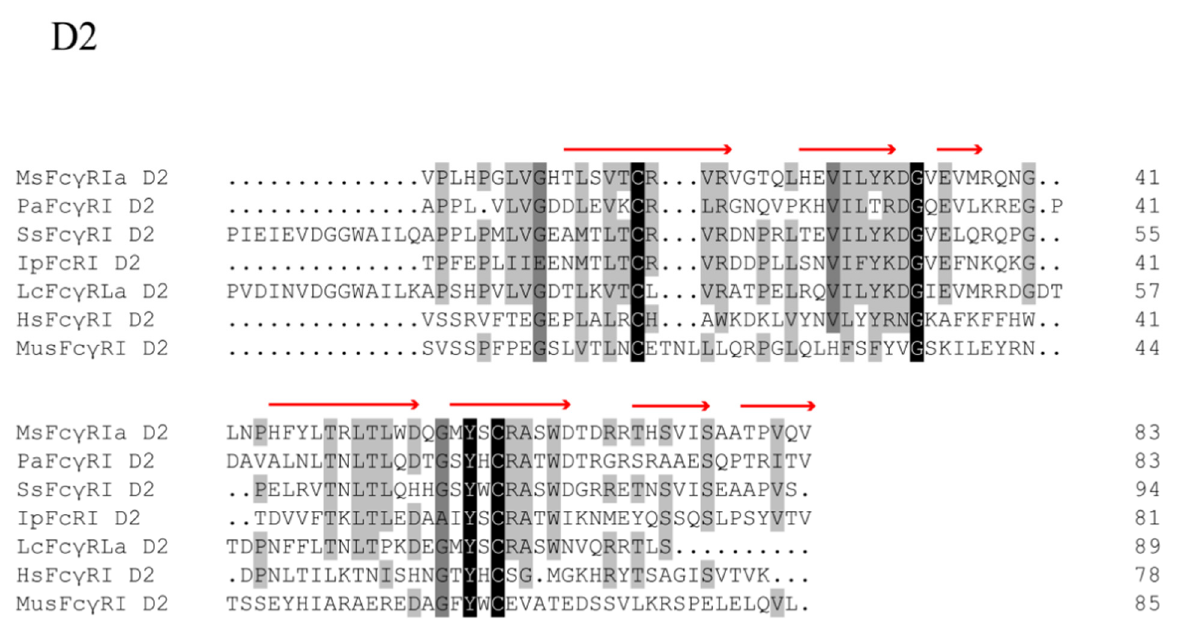
Figure 2. Analysis of MsFc γ RI α protein sequences. ( A ) Schematic representation of MsFc γ RI α protein. The red line on the left and the purple line on the right represents signal peptide and low complexity domain, respectively. ( B ) Amino acid alignments of D1 and D2 of largemouth bass, ayu, Atlantic salmon, channel catfish, large yellow croaker, human and mouse representative Fc γ Rs. Hatched boxes indicate conserved cysteines, and dashes (-) represent gaps. MsFc γ RI α : Largemouth bass Fc γ RI α (ULE36159.1); PaFcRI: Ayu (MG687271); SsFc γ RI: Atlantic salmon Fc γ RI (XM014162558); IpFcRI: Channel catfish FcRI (DQ286290); LcFcRL α : Large yellow croaker FcRLa (XM010738182); HsFc γ RI: Human Fc γ RI (L03418); MusFc γ RI: Mouse Fc γ RI (AF143170). Red arrows represent the predicted β -strand for MsFc γ RI α . ( C ) Structural comparison of MsFc γ RI α with HsFc γ RI α (PDB; 3RJD, left panel). The aligned residues are shown in orange and blue, while the parts that are not aligned are shown in lighter shades of the same colors.